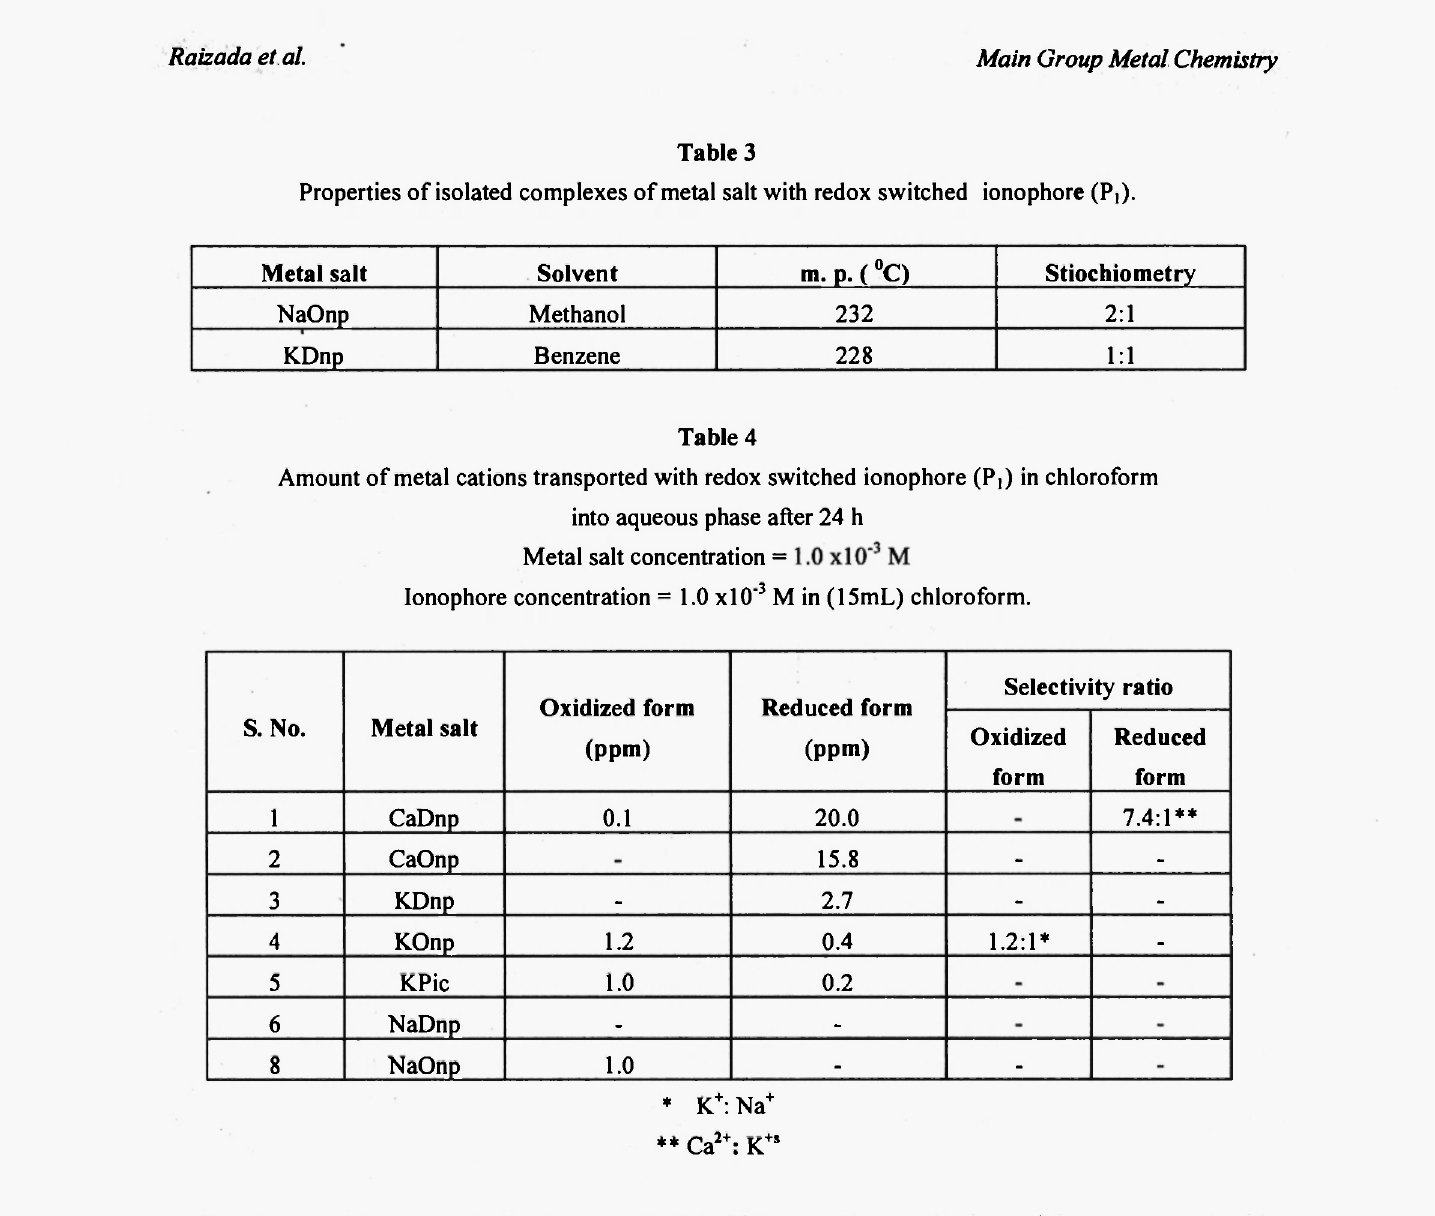
Properties of isolated complexes of metal salt with redox switched ionophore